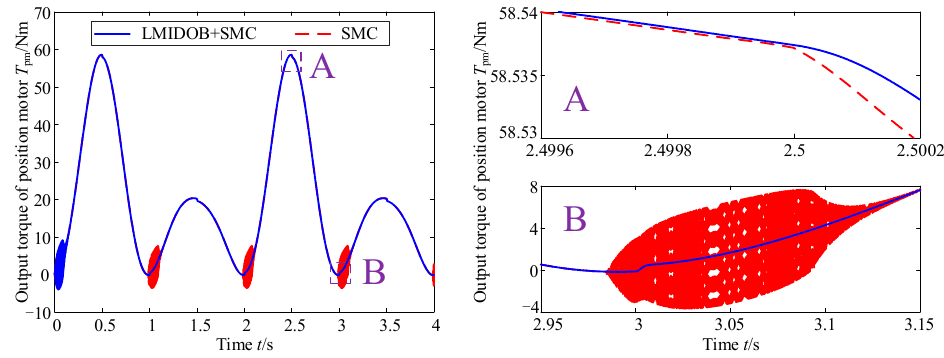
Figure 10. Output torque of position motor at the variable stiffness condition.